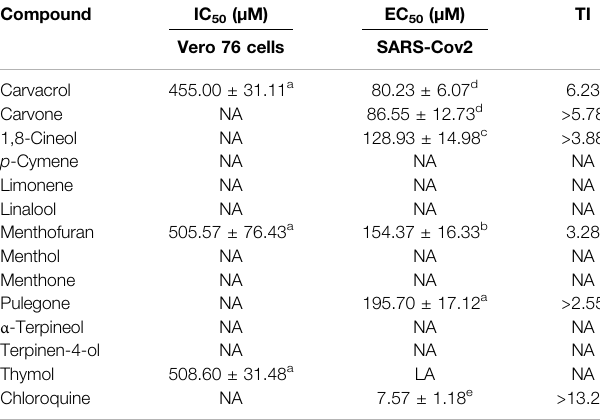
TABLE 2 | Cytotoxic and antiviral activity of selected